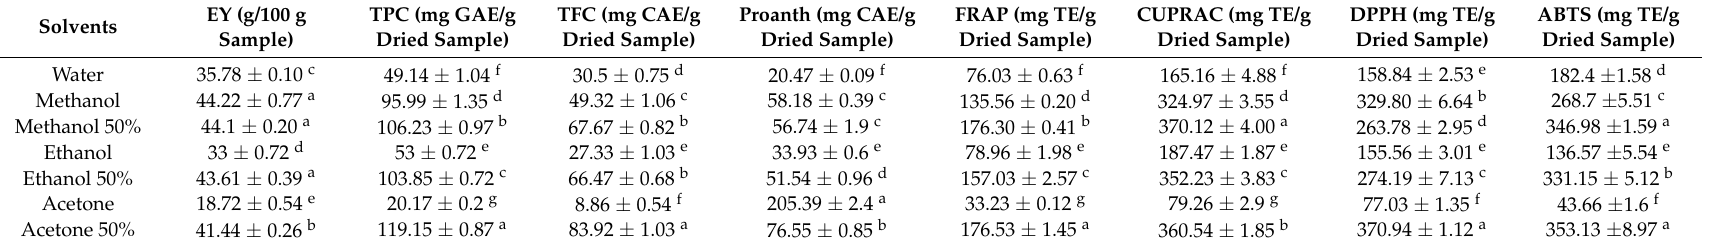
Table 2. Effect of solvents on extraction yields (EY), phenolic content and antioxidant capacity of the Tuckeroo